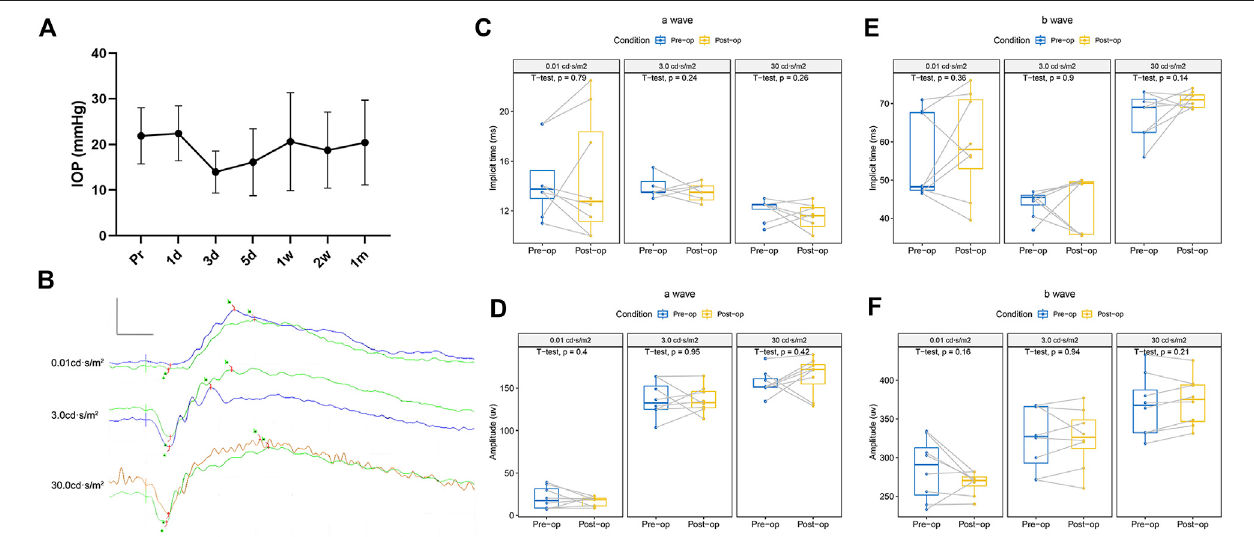
FIGURE 5 | Variation of IOP and function before and 1 month after the operation in the eye with HA-engineered hydrogel coverage. (A) The IOP fl uctuated within 1 week after the operation and recovered spontaneously within 1 month, with no statistical difference. (B) A splicing ERG diagram of the left eye was recorded before (green line) and 1 month after the retina coverage with the HA-engineered hydrogel. Scale bar: 200 uv and 20 ms. (C – F) Left eyes ’ implicit time and amplitude of the a-wave and b-wave before and 1 month after the retina coverage with the HA-engineered hydrogel.